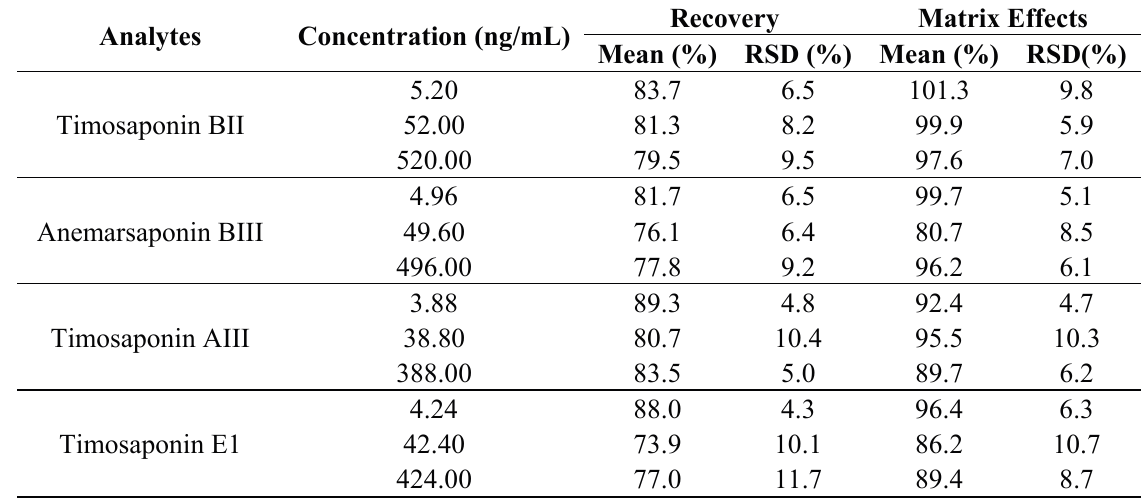
Table 3. Recovery and Matrix effects for four analytes in rat plasma ( n = 5).